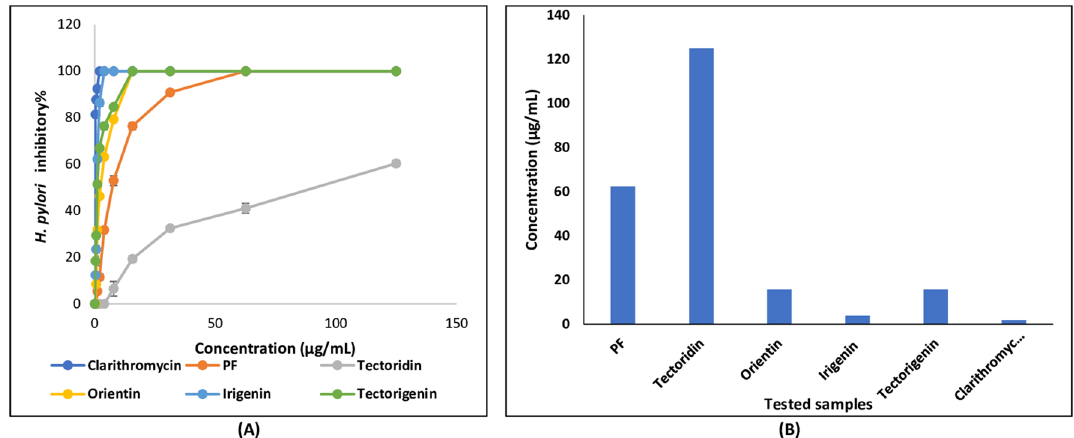
Figure 2. ( A ) Percentage inhibition and ( B ) MIC values of I. confusa underground PF and isolated compounds against H. pylori . All determinations were carried out in a triplicate manner and values are expressed as the mean ± SD; PF polar